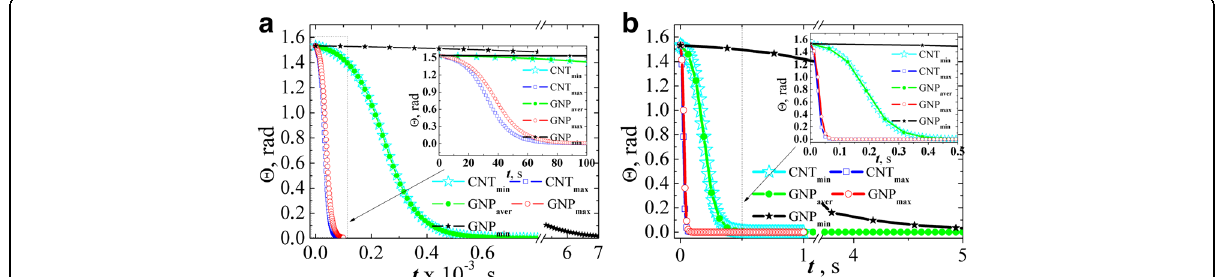
Fig. 6 The evolution of the angle of carbon filler particles inclination relative to the field direction estimated in ellipsoids approximation for AC electric field strength 1 kV/m ( a ) and 36 kV/m ( b